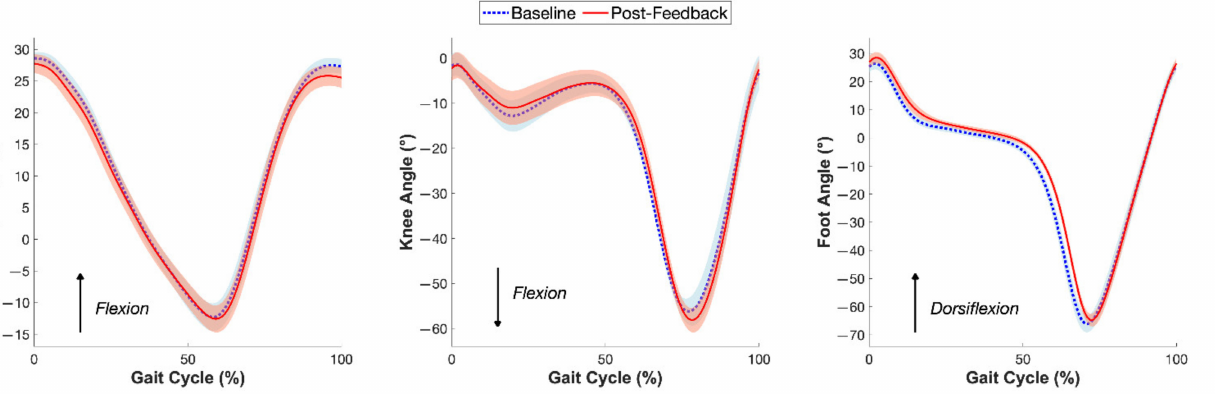
Figure 4. Mean gait cycle at baseline (blue) and post-feedback (red) of the hip joint, knee joint, and foot of the dominant leg ( n = 7). The shaded regions indicate the 95% bootstrapped confidence interval around the mean for each